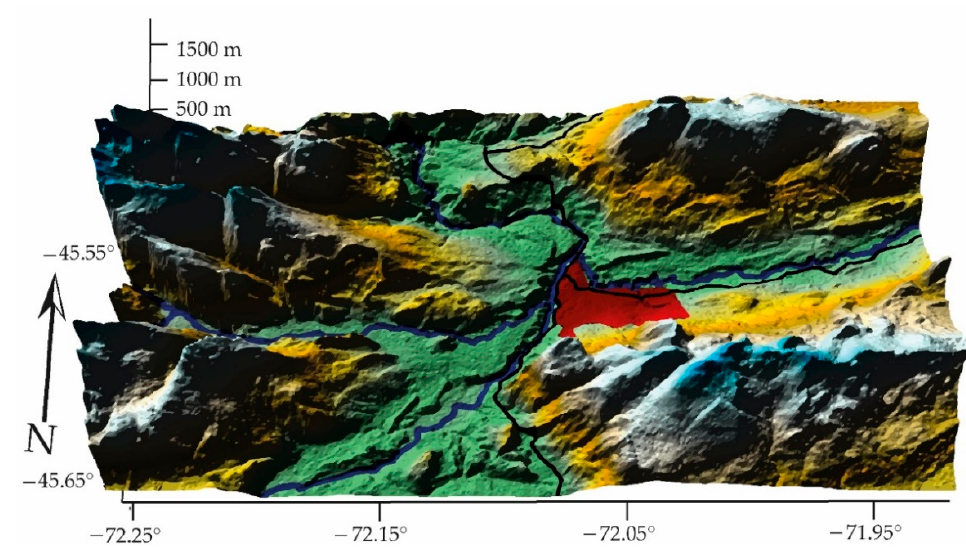
Figure 11. Coyhaique Geomorphology, C K, Coyhaique =0.87 (GCS, WGS84). (d) Las Encinas station is in the city of Temuco, which is in a straight line 85.4 km from Puerto Saavedra, with access to the Pacific Ocean. It is located in the depression between the Cordillera de los Andes (highest peak, Lanín volcano, 3747 m above sea level) and the Cordillera of the Coast (highest peak, Cerro Alto Nahuelbuta, 1565 m above sea level) (Figure 12):